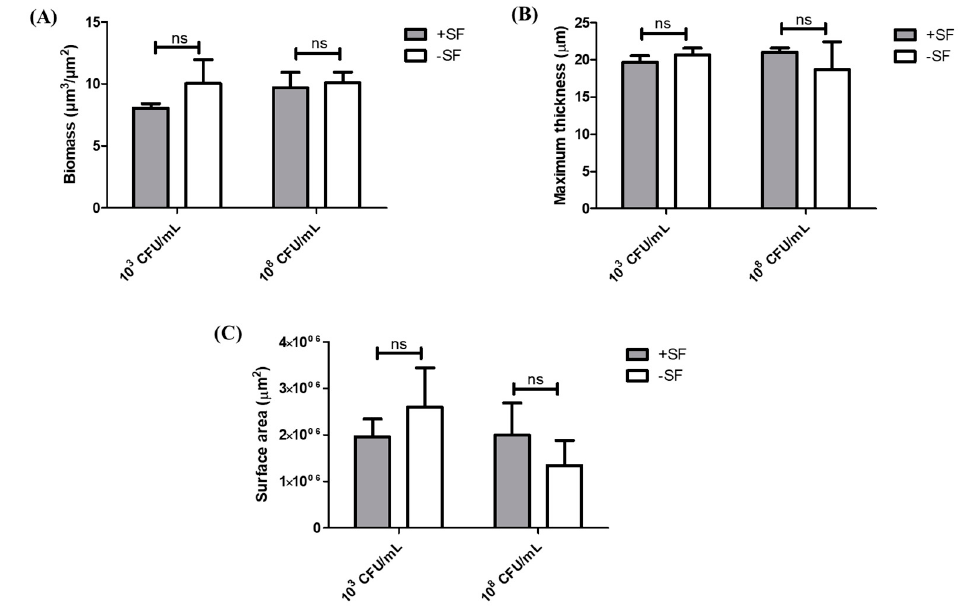
Figure 4. COMSTAT analysis—( A ) biomass, ( B ) thickness, and ( C ) surface areas. ns = not significant.